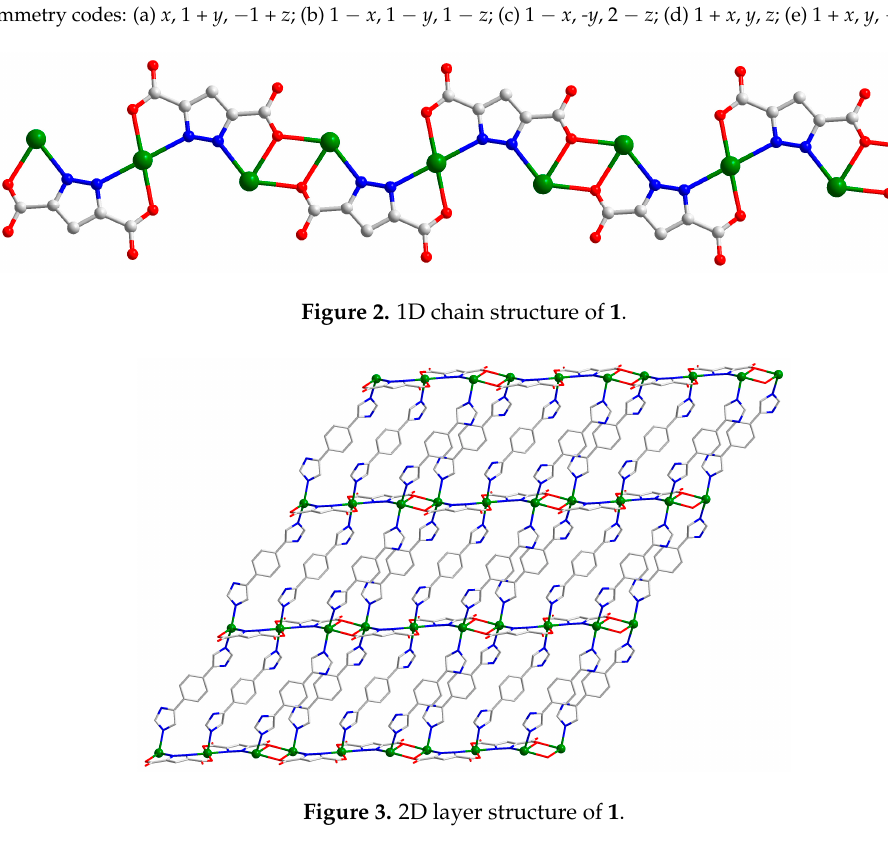
Figure 3. 2D layer structure of 1 .